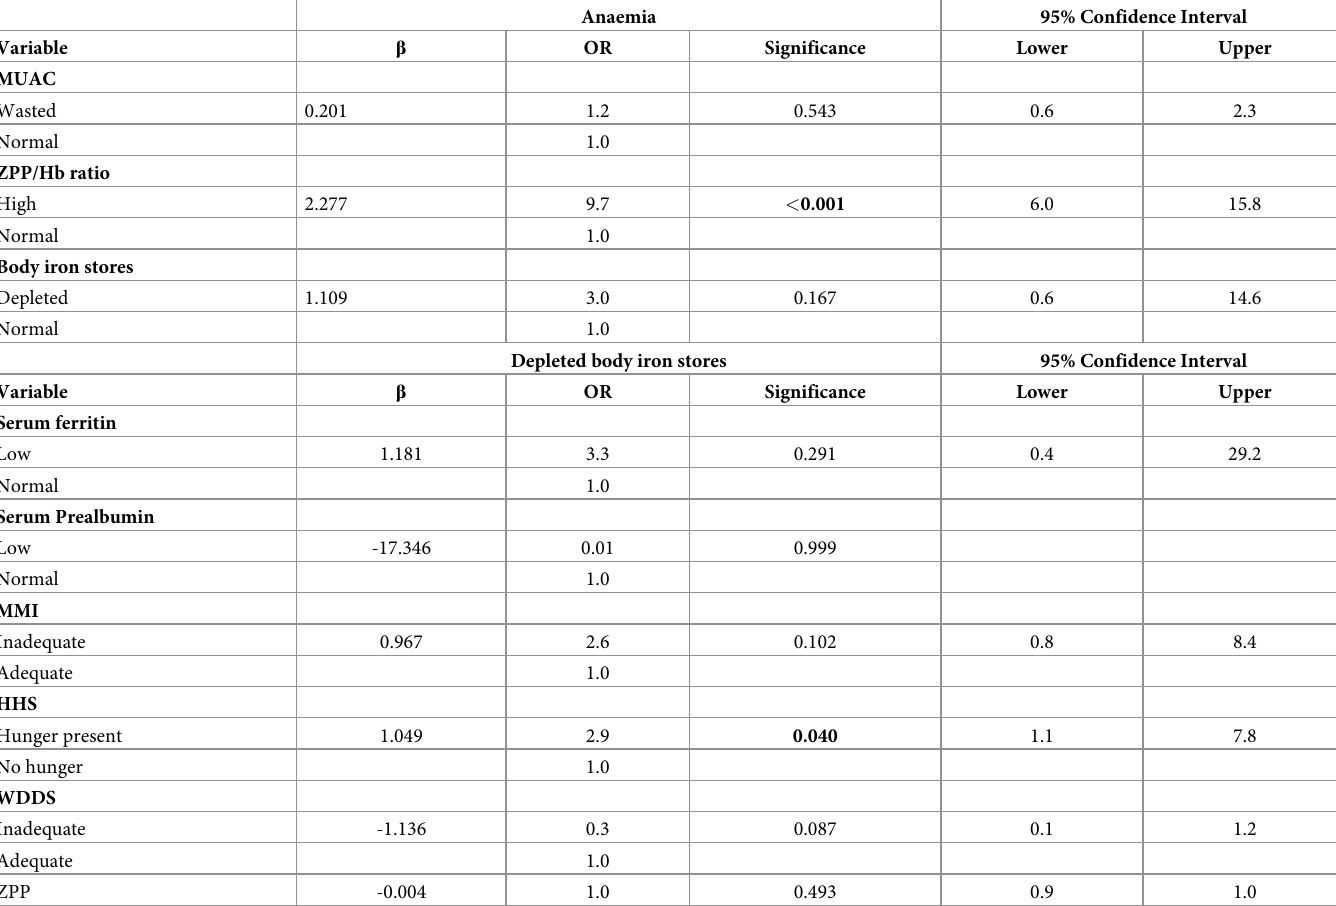
Table 5. Predictors of anaemia and depleted body iron